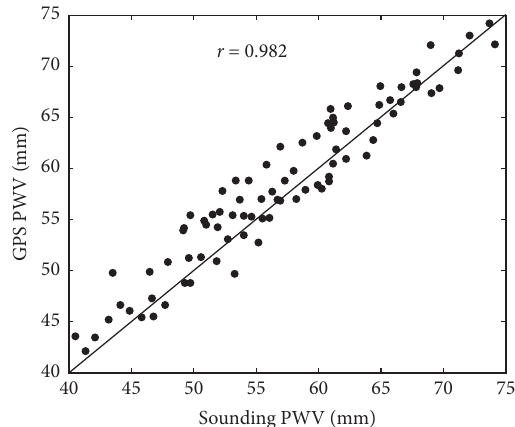
Figure 2: The scatterplots of PWV (mm) at UTC 0000 derived from GPS and sounding data at Nanchang site for June-August 2017. r is a correlation